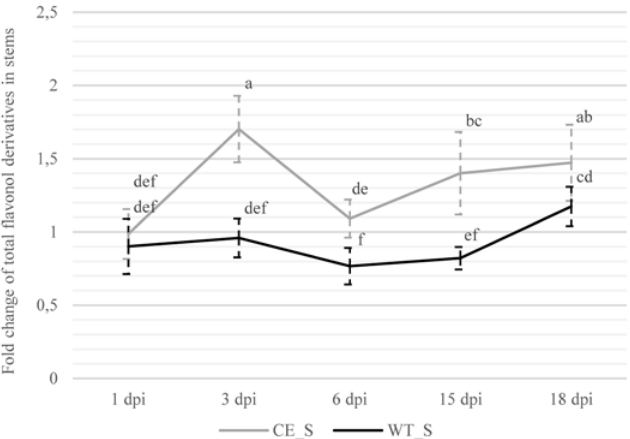
Figure 4. Fold changes (infected/control) of total analyzed flavonols in stems (S) of susceptible (CE; Celeia) and resistant (WT; Wye Target) hop cultivars. Data are presented as mean ± SD. Values below 1 indicate decreases in content compared to the control. Data were analyzed by one-way ANOVA and Duncan’s post hoc test. Different letters denote statistically significant differences at p ≤ 0.05 .